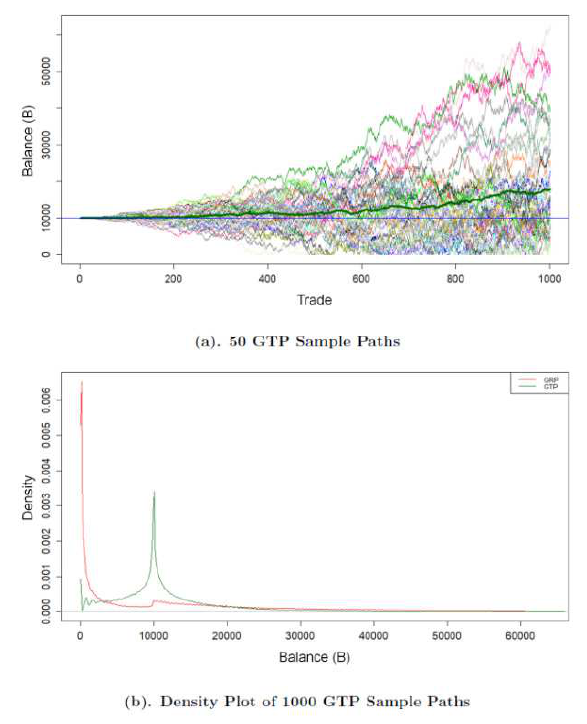
Figure 8. Multiple GTP